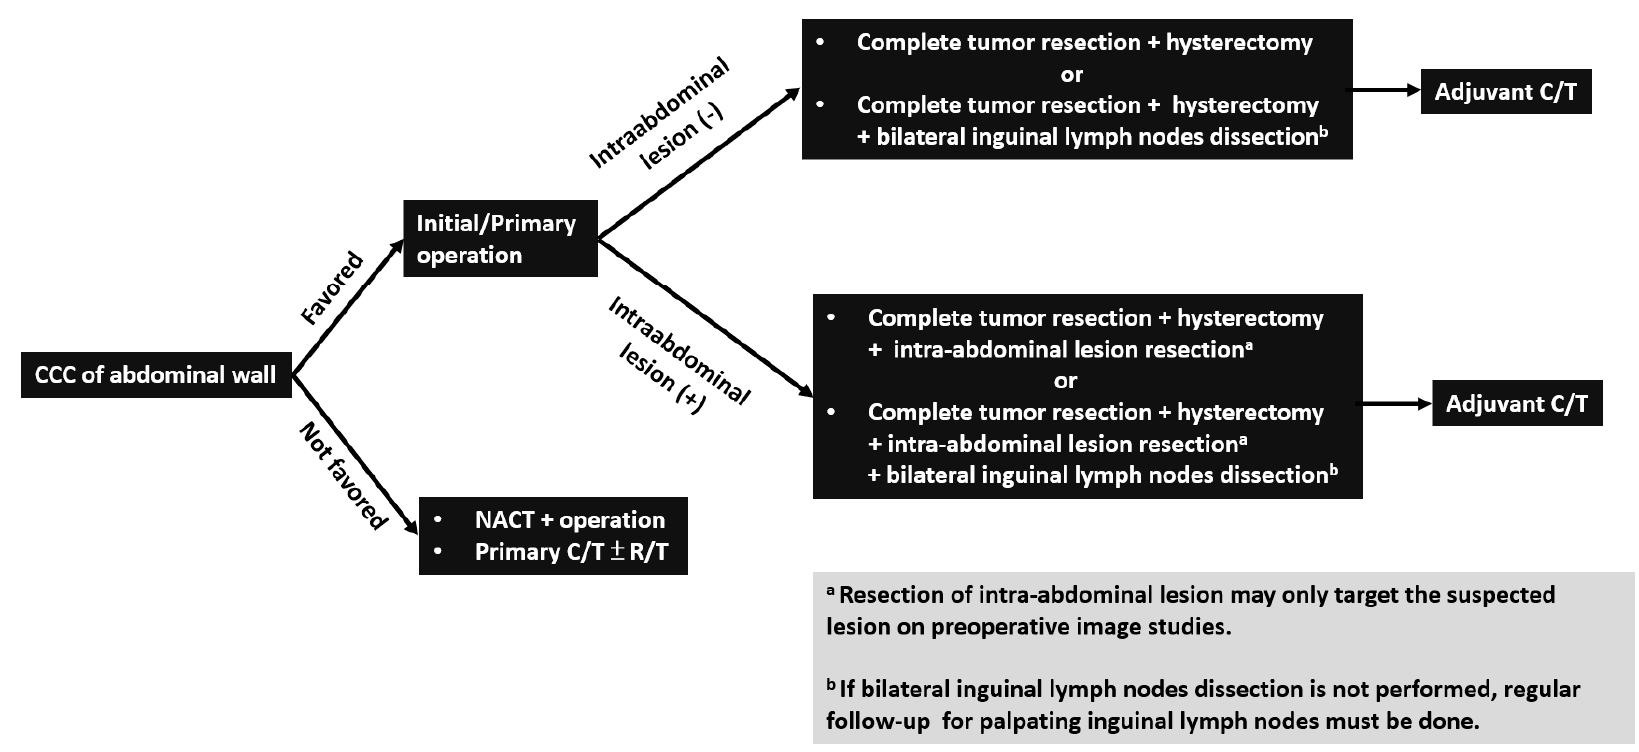
Figure 3. Flowchart of management for patients with clear cell carcinoma (CCC) of abdominal wall. Note: CCC, clear cell carcinoma; NACT: neoadjuvant chemotherapy; C/T: chemotherapy; R/T: radiotherapy.